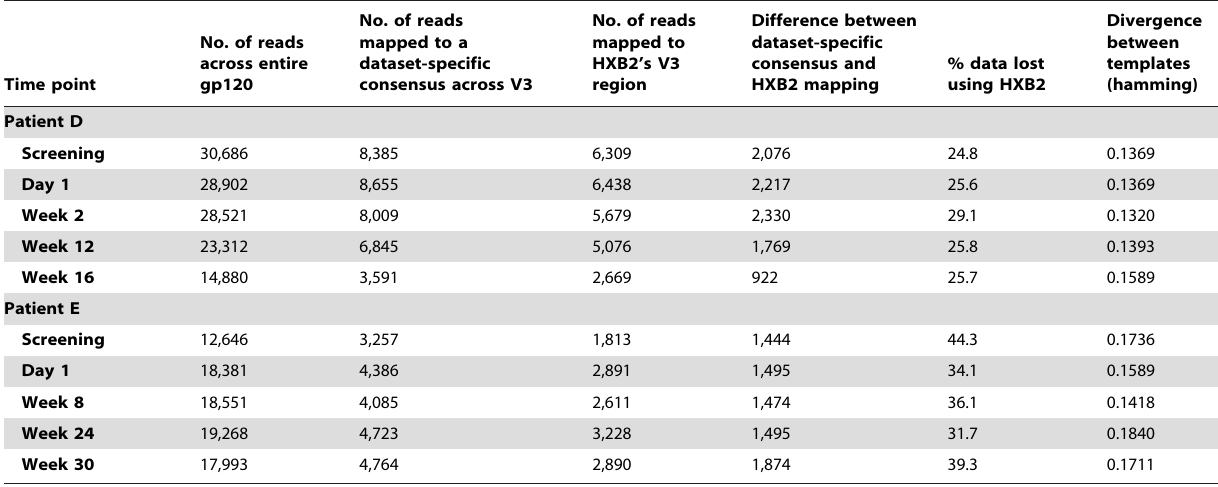
Table 1. Read extraction